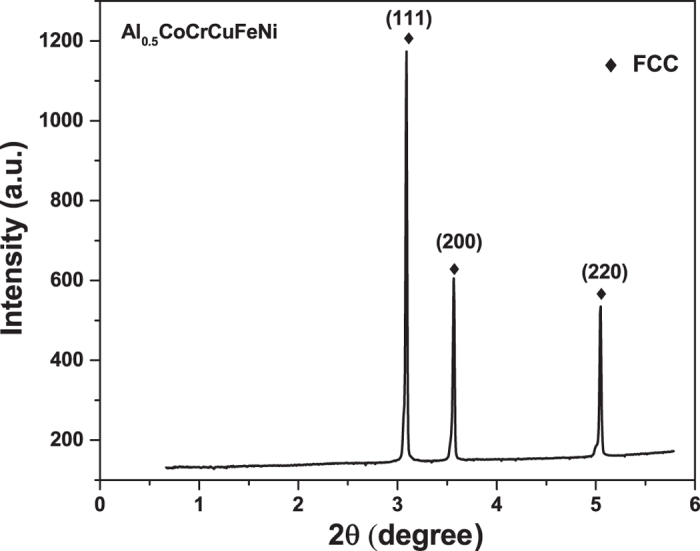
Diffraction pattern of the initial microstructure of theAl0.5CoCrCuFeNi HEA.